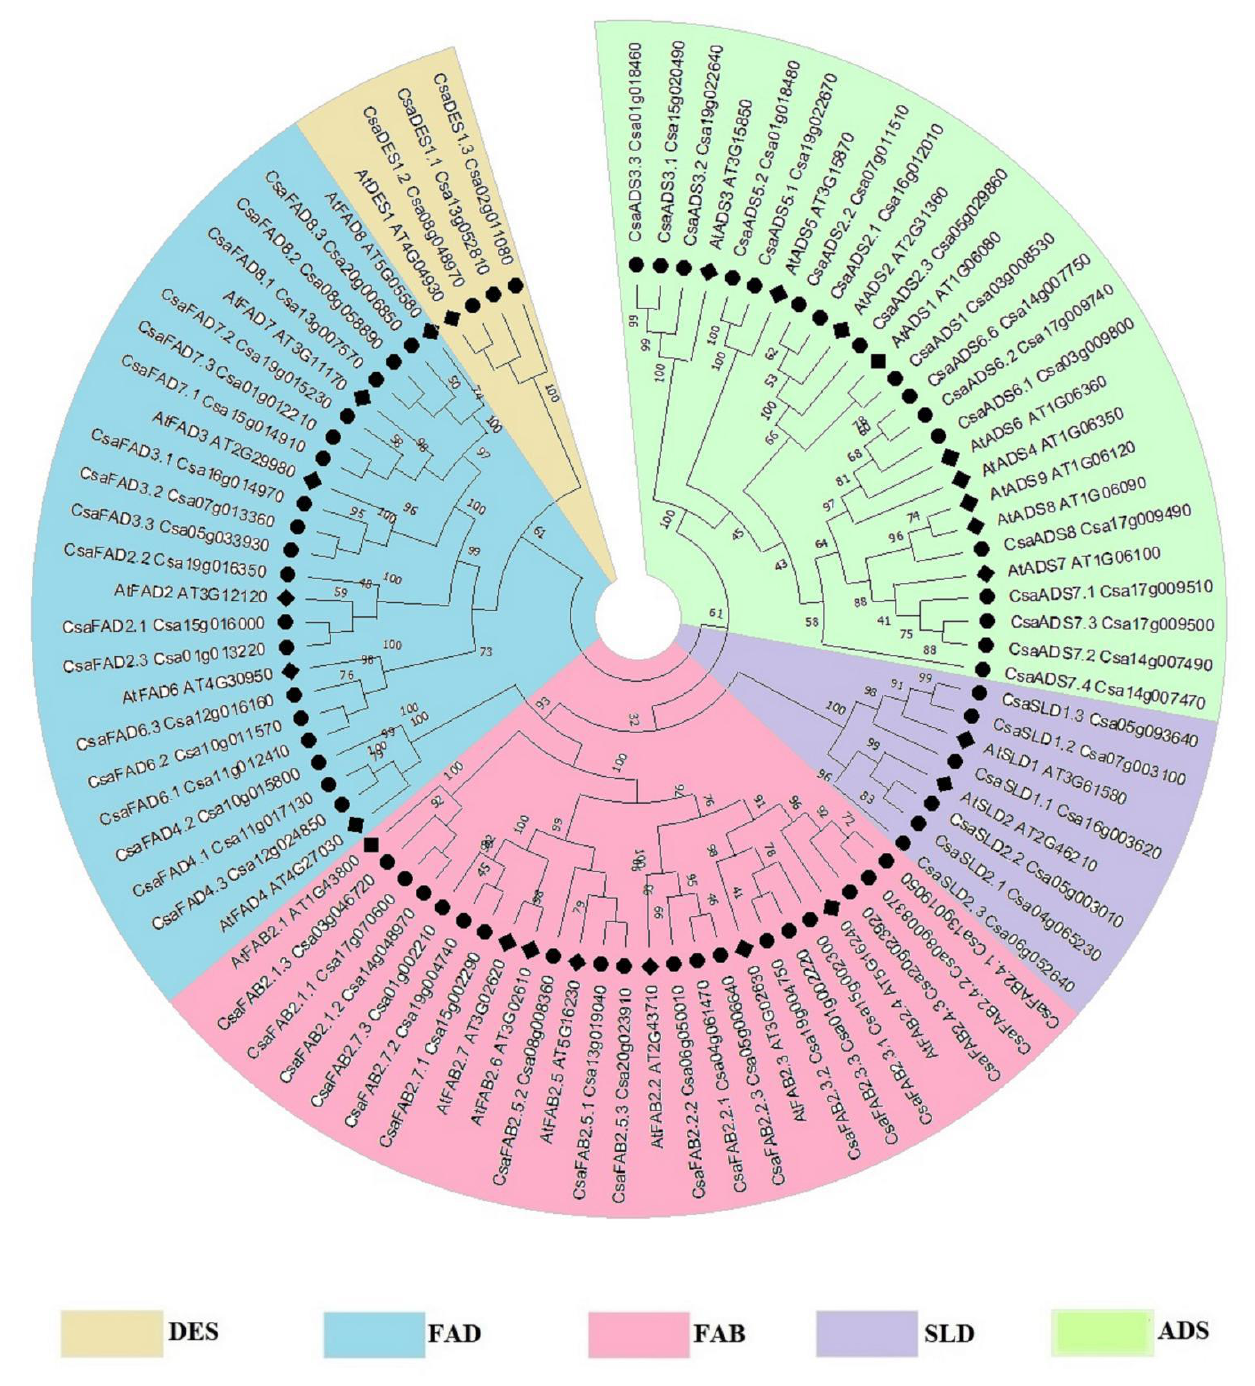
Figure 2. Evolutionary relationships of fatty acid desaturases. The tree was inferred using the Neighbor-Joining method [50]. The evolutionary distances were computed using the p-distance method [51] and are in the units of the number of amino acid differences per site. The analysis involved 87 amino acid sequences. Desaturase families were clustered into five classes, indicated by different colors. Numbers indicate the bootstrap value (%). Evolutionary analyses were conducted in MEGAX [52].